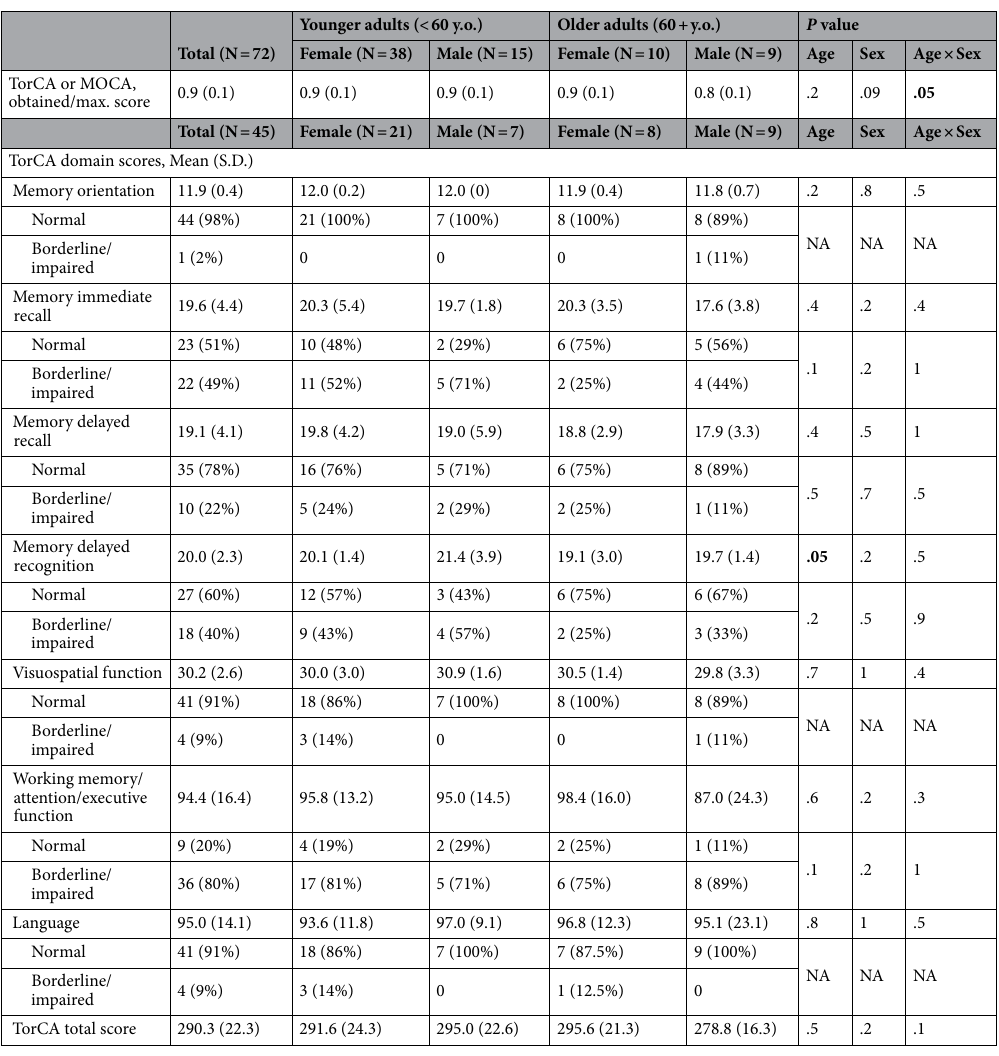
Table 3. Neuropsychological assessment scores stratified by age and sex. Data presented as Mean (S.D.). Patients admitted to ICU and/or with abnormal brain MRI findings are excluded. Linear and binary regressions adjusted for combined past medical history and symptom duration. All neuropsychological scores where z-scores were not computed were additionally adjusted for years of education. Significant values are in